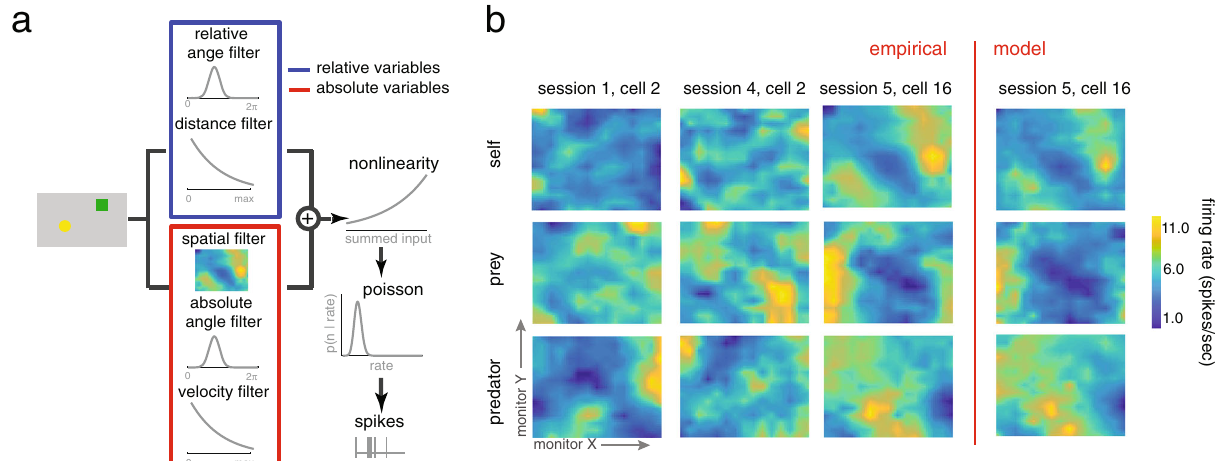
Fig. 2 Examples of multi-agent world-centric mapping functions in dACC. a Schematic of the analysis approach we took, see “ Methods ” and ref. 34 . b Maps of the responses of three example neurons with signi fi cant spatial selectivity, chosen to illustrate the typical types of responses we see. X - and Y -dimensions in each subplot correspond to X - and Y -dimensions of the computer monitor; the Z -dimension corresponds to the fi ring rate of that cell. Yellower areas indicate spots in which entry tended to result in spiking. Top row: responses to self position. Middle row: responses to prey position. Bottom row: responses to predator position. Rightmost column: responses of the model (see “ Methods ” ) for the same neuron whose observed responses are shown in the adjacent